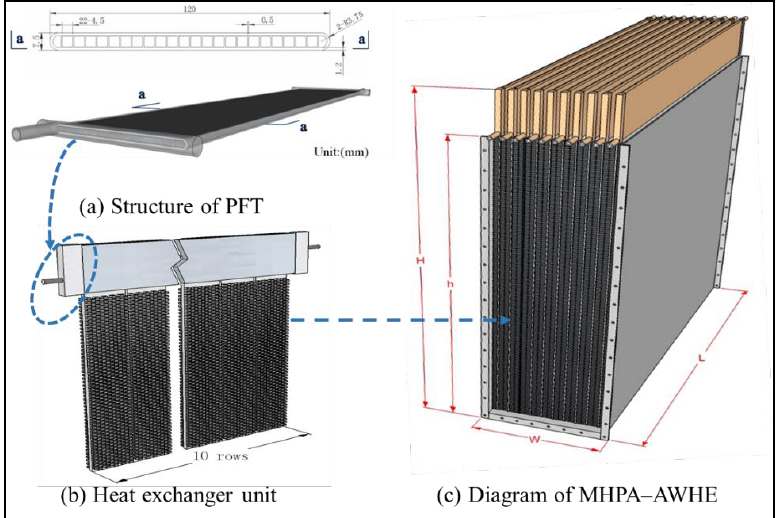
Figure 2. MHPA-AWHE. Figure 2.